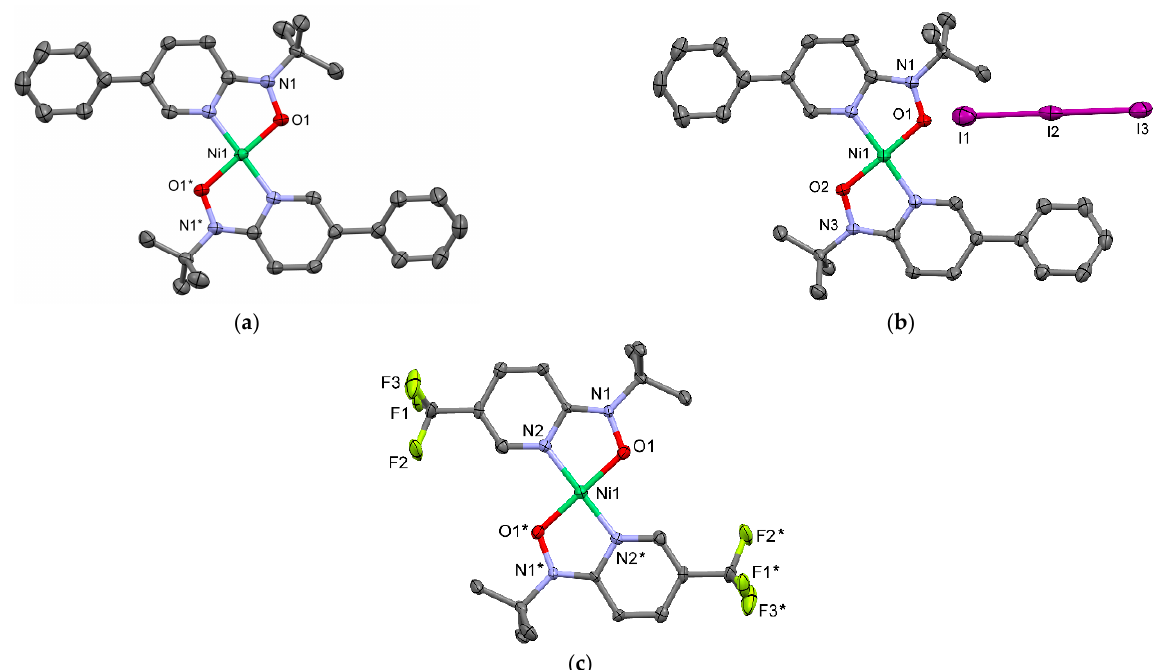
Figure 16. X-Ray crystal structures of ( a ) [Ni(phpyNO) 2 ], ( b ) [Ni(phpyNO) 2 ]I 3 , ( c ) [Ni(tfpyNO 2 )] with thermal ellipsoids at the 50% probability level. Hydrogen atoms are omitted. Selected atomic numbering is also shown. A half of molecule is crystallographically independent for ( a ) and ( c